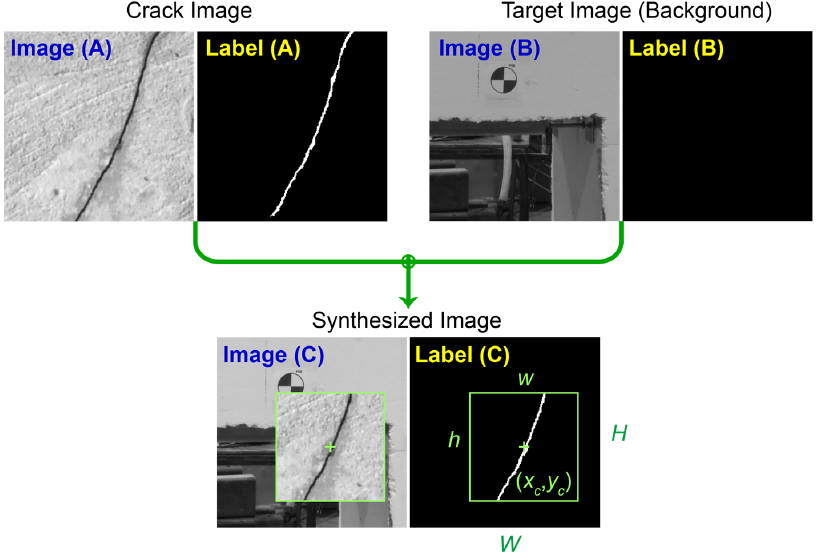
Figure 11. CutMix data synthesis procedure.